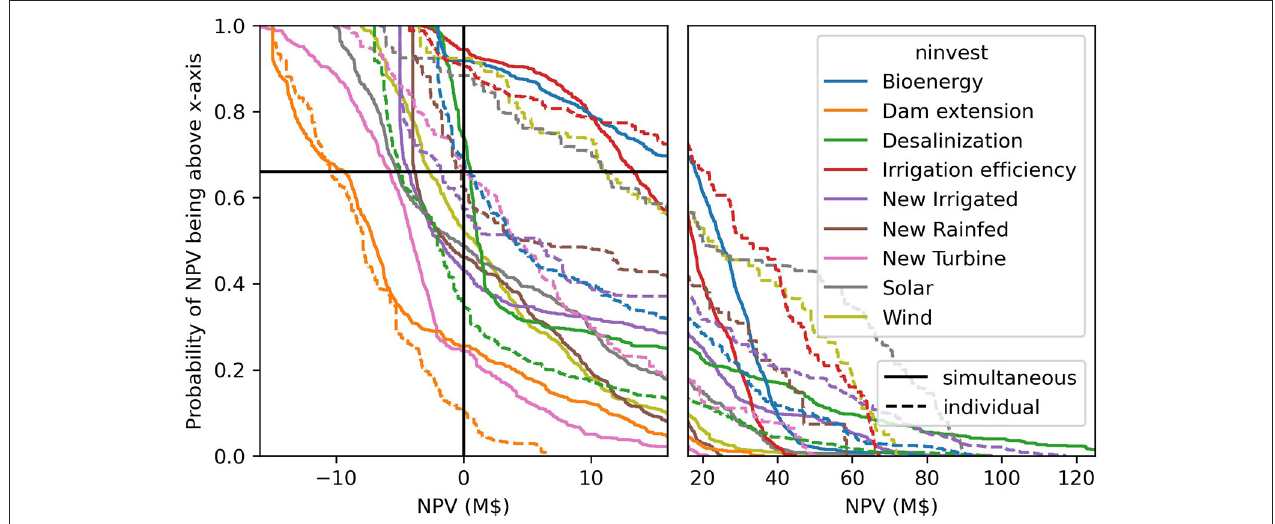
FIGURE 6 | Investment NPV empirical distribution function with and without other investments. The NPV of each investment is calculated through with-without analysis for each scenario considering (1) optimal investments within each scenario (solid line), and (2) ignoring all other investments (dashed